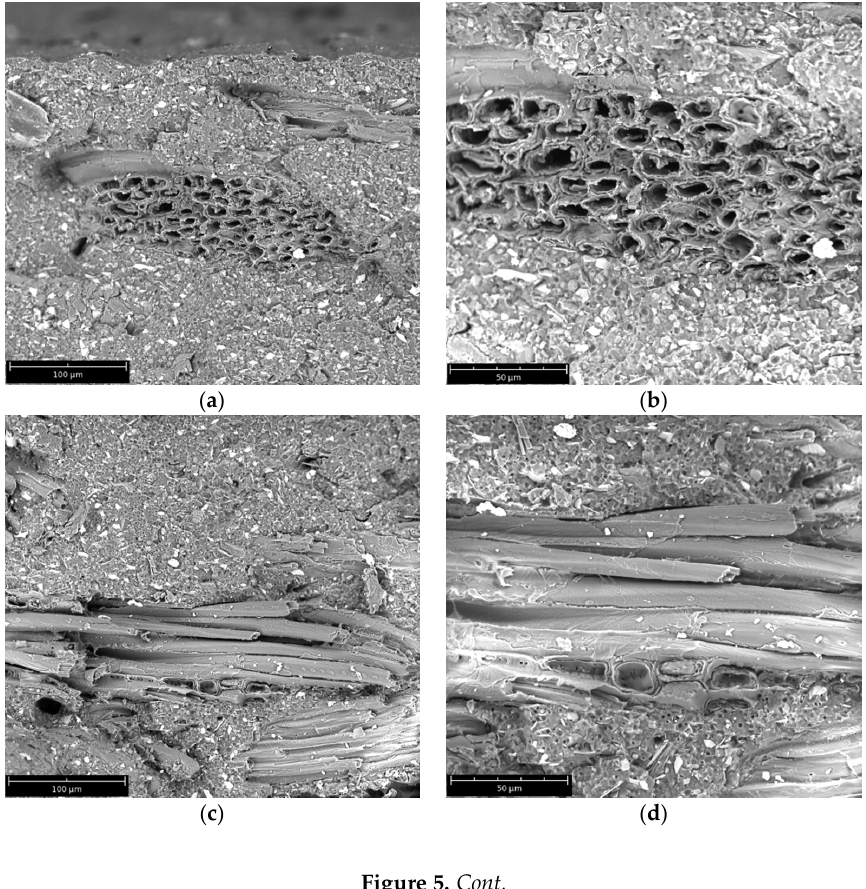
Figure 5. Cont . Figure 5.